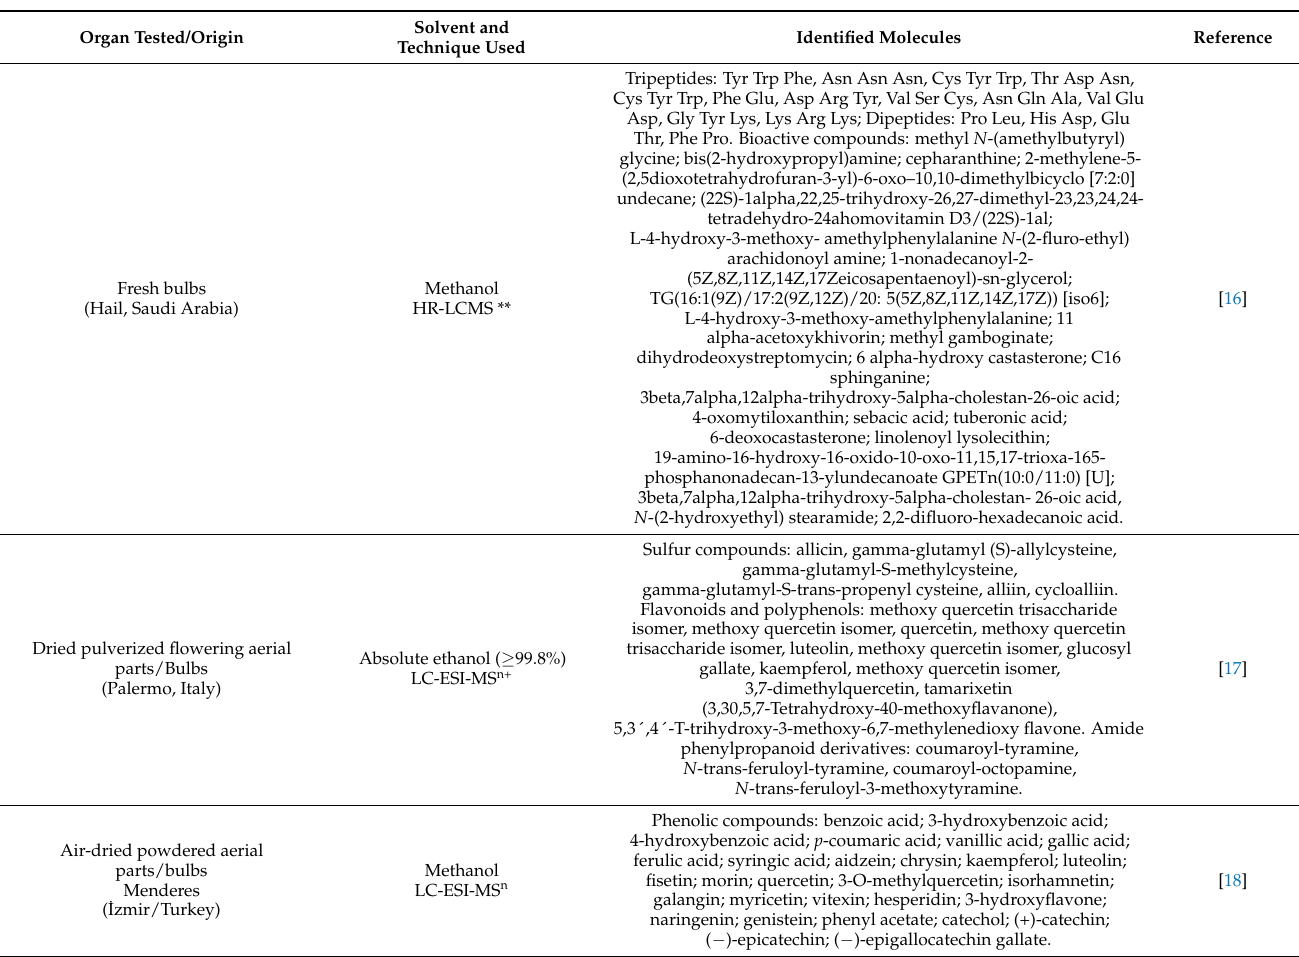
Table 8. Review of the phytochemical compounds identified in A. subhirsutum L. (bulbs and aerial parts) extracts from different